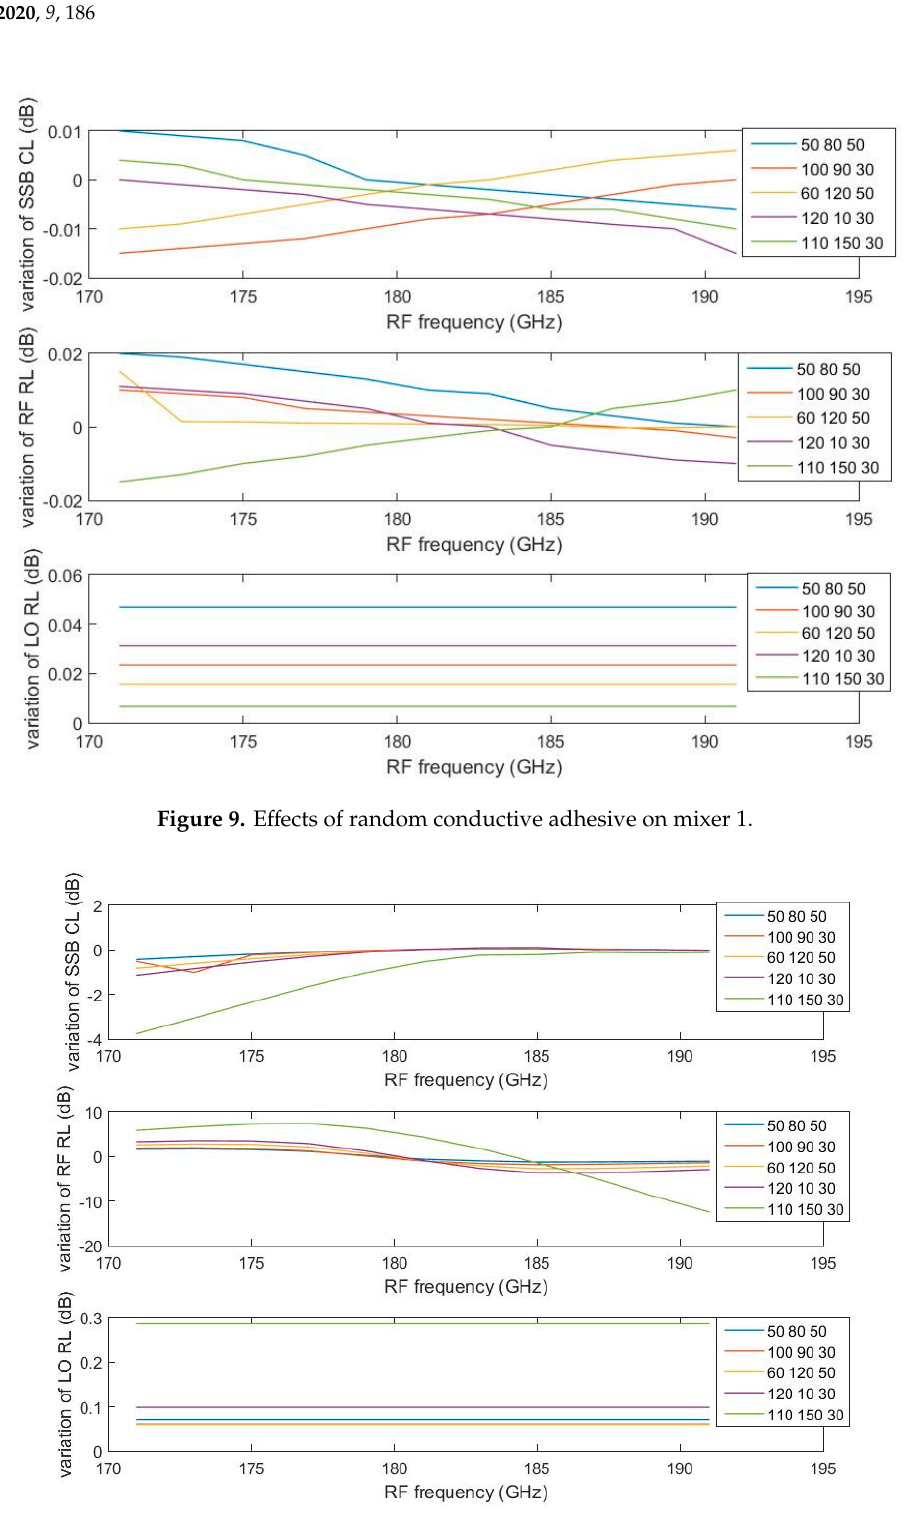
Figure 10. Effects of random conductive adhesive on mixer 2. Table 2. Variation range of mixer 1 and mixer 2.